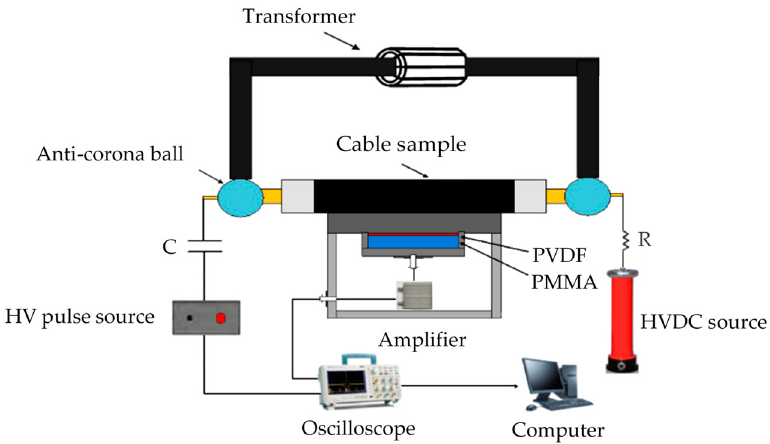
Figure 3. Schematic diagram of the experimental setup. Table 1. The relationship between the current, the temperature of the conductor, and the temperature of the insulation shield layer.